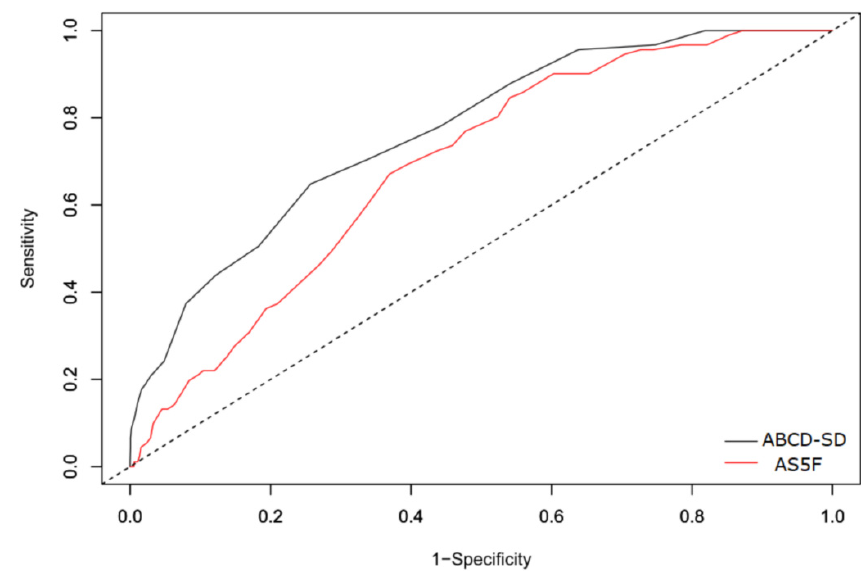
Figure 2. ABCD-SD score used for the prediction of paroxysmal atrial fibrillation in the validation group (AUROCC 0.769) compared with AS5F score (AUROCC 0.689, p = 0.022). Abbreviations: AUROCC, the area under the receiver operating characteristic curve.